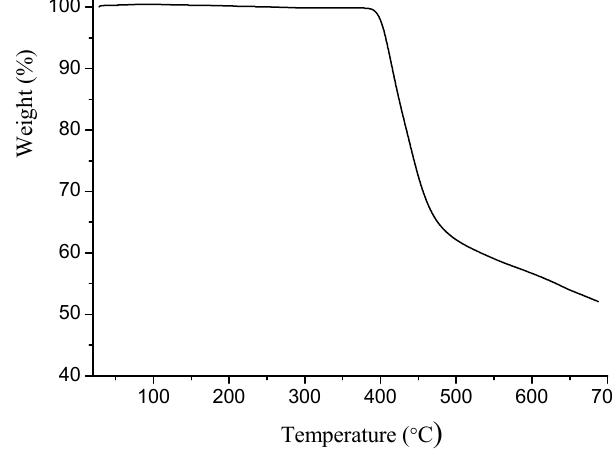
Figure 6. Thermal analysis curve of complex 1 .